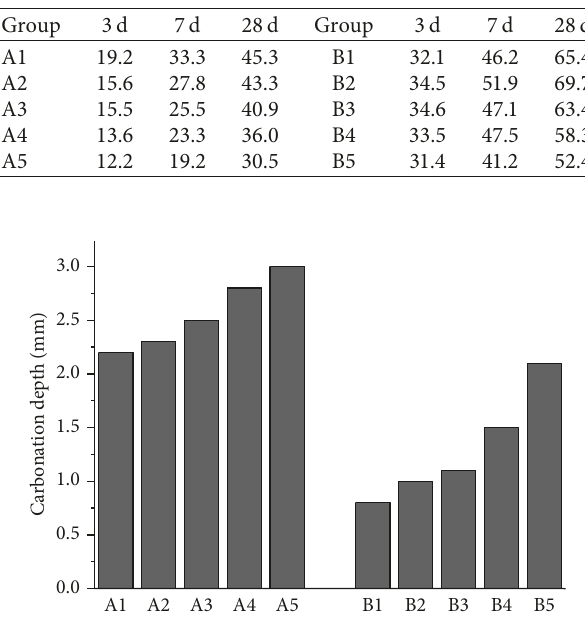
Figure 2: Concrete carbonation depth.